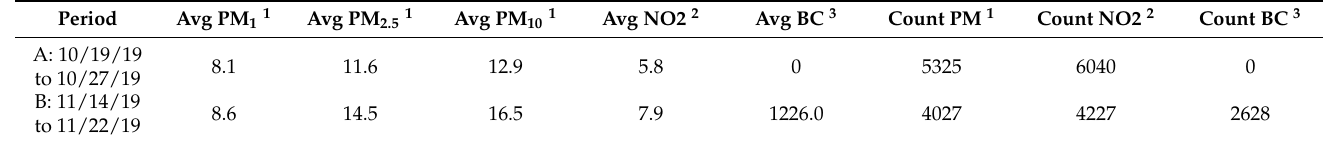
Table 2. Overview of the two periods of acquisition; pollutants values in µ g/m 3